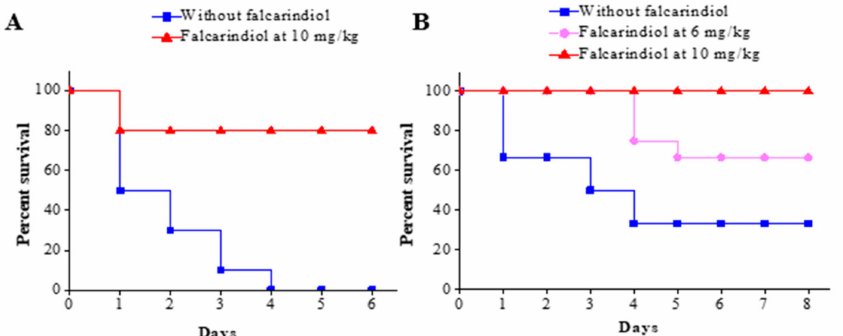
Figure 5. Attenuation of P. aeruginosa pathogenicity by falcarindiol. Kaplan–Meier survival curves of the burned mouse model are plotted with high infection dose (5 × 10 7 CFU) of P. aeruginosa ( A ) and lower infection dose (5 × 10 5 CFU) ( B ). Mice in the control groups (without falcarindiol) were infected but treated with saline containing 5% ethanol. Log rank analysis (Mantel–Cox) was used to compare the survival rates between the groups. Significant di ff erences were observed between the two groups in the first experiment (n = 10 per group) ( A ) ( p < 0.0001), and between the control and both the 6 mg / kg ( p < 0.05) and the 10 mg / kg ( p < 0.005) groups in the second experiment (n = 12 per group) ( B